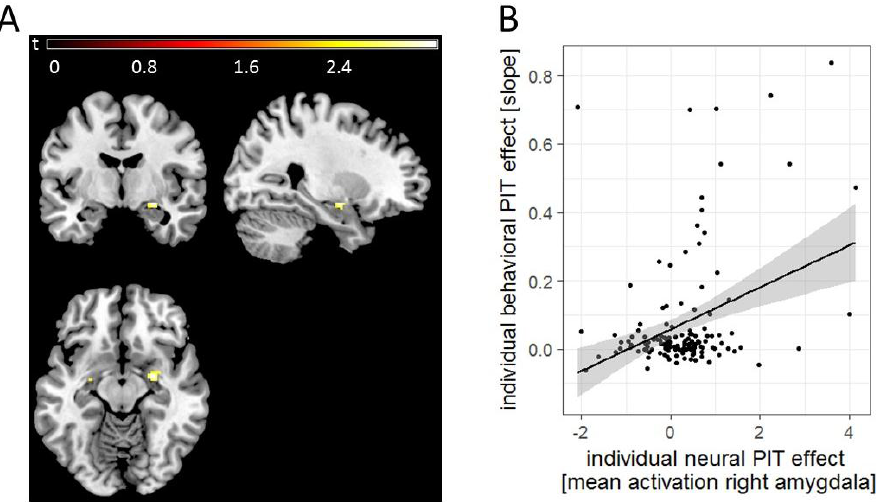
Figure 4. ( A ). Neural PIT effect in the right amygdala for the whole group ( n = 139). For illustrational purposes, this effect was masked for the bilateral amygdala (region of interest (ROI) derived from wake Forest University (WFU) Pick Atlas). ( B ). The PIT-related activation in the right amygdala positively correlated with the behavioral PIT effect.